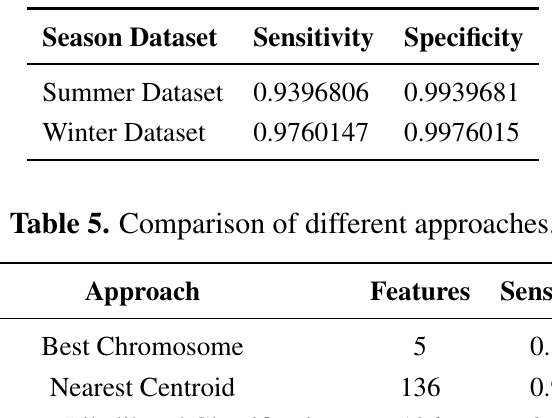
Table 4. Sensitivity and specificity from the final models.